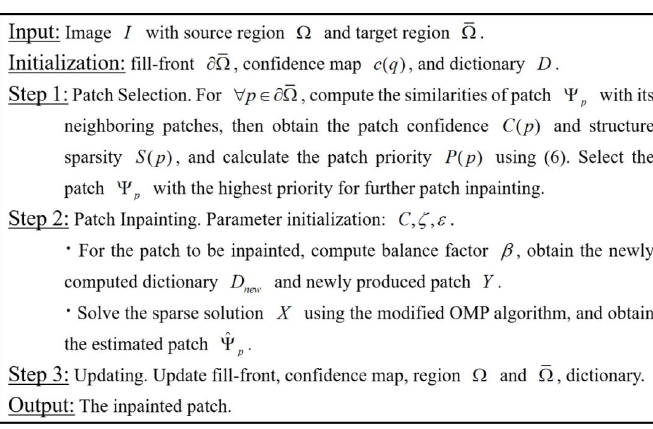
Figure 2. The Procedure of Adaptive Patch Inpainting Algorithm.